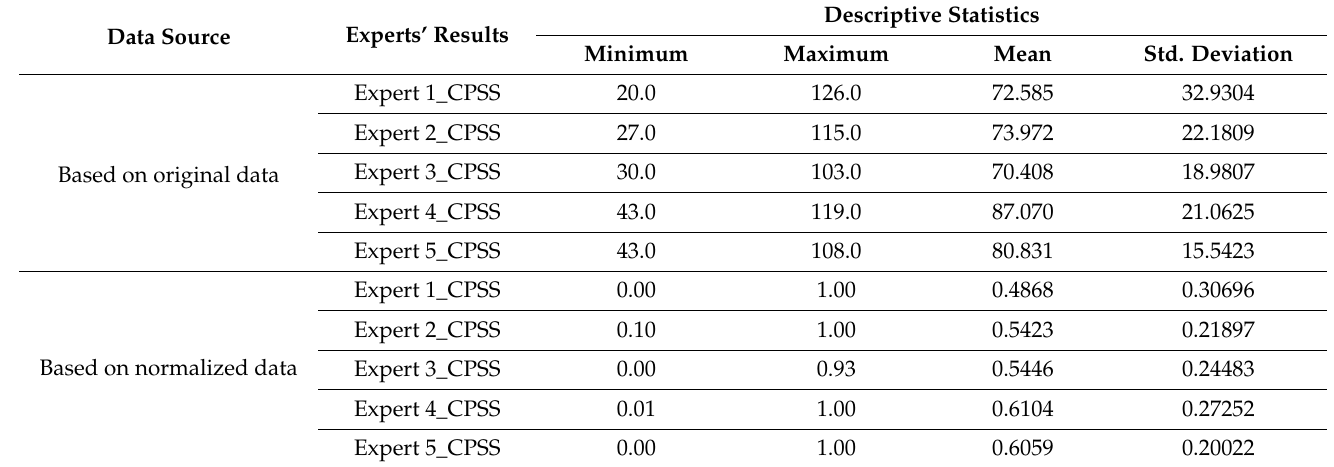
Table 3. Descriptive statistics (minimum, maximum, mean, and SD value) of each expert’s CPSS results. (The CPSS score ranges from 0 to